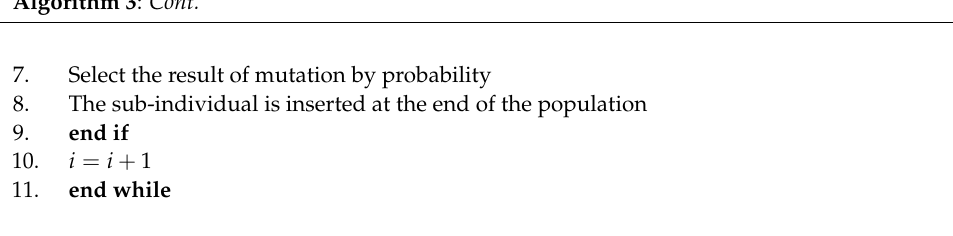
Table 2. Simulation parameter configuration for GA.